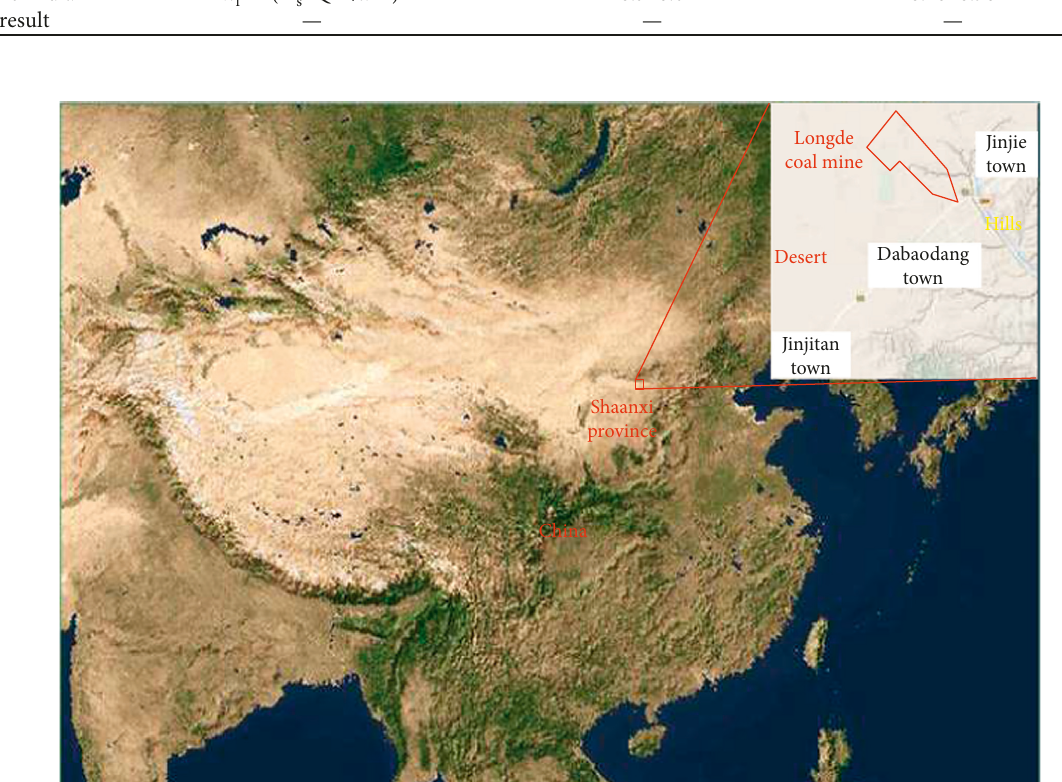
Figure 2: Landscapes of Longde mine field.